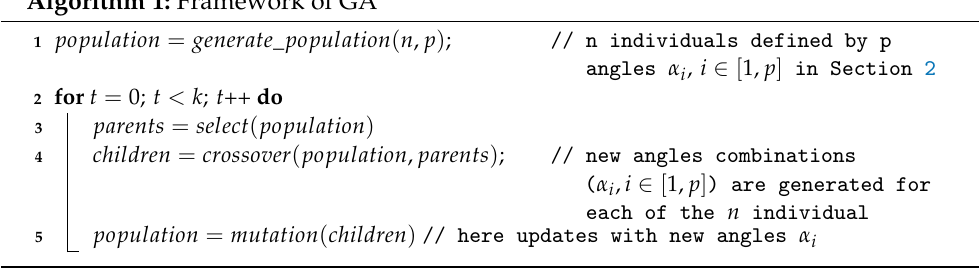
Algorithm 1: Framework of